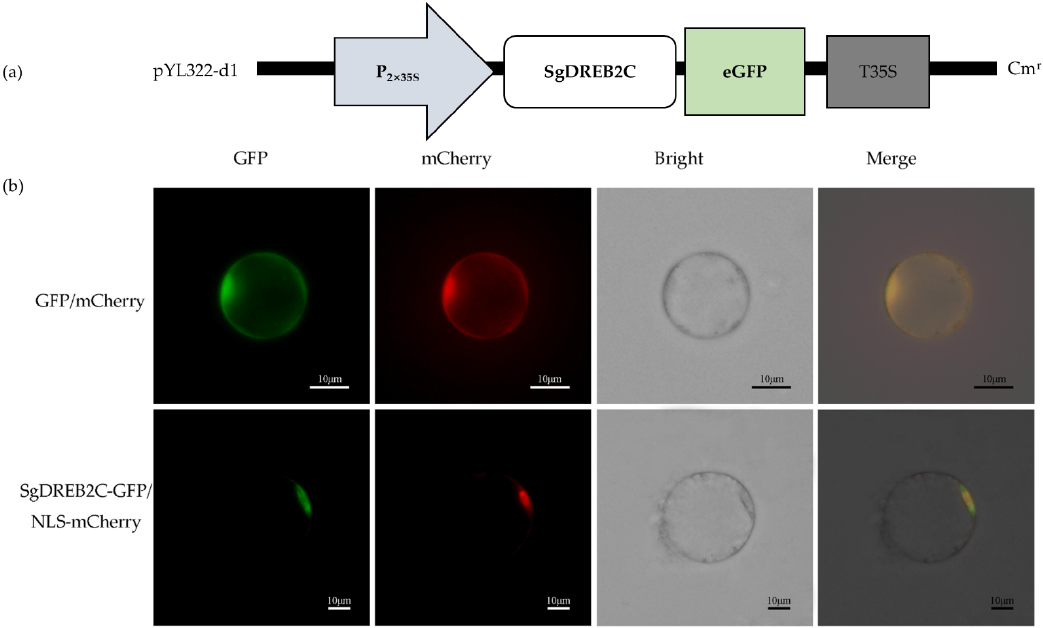
Figure 2. Subcellular localization of SgDREB2C. ( a ) Schematic draft of p35GFP-SgDREB2C construct used for subcellular location assay; ( b ) Confocal images of rice protoplasts co-expressing SgDREB2C-GFP and NLS-mCherry or GFP and mCherry as control.